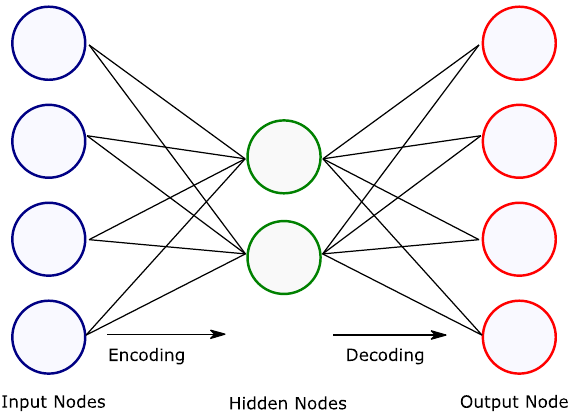
Figure 4. Simple autoencoder architecture with one hidden layer.